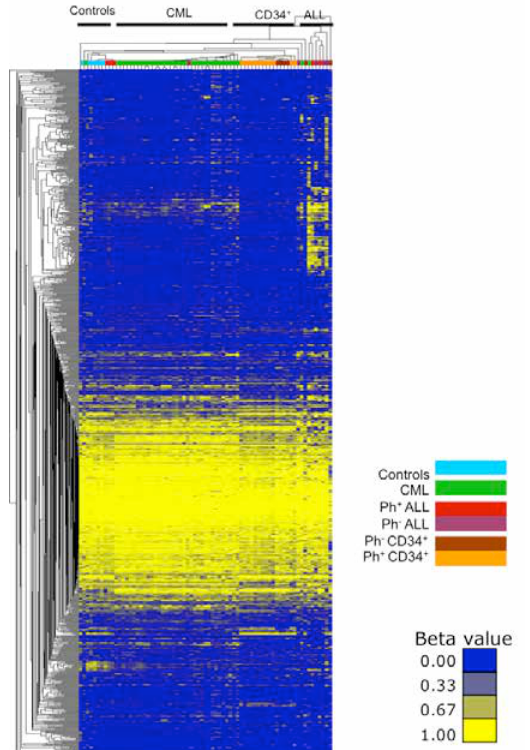
Figure 1: DNA methylation analysis of homogenous cancers. Two- dimensional unsupervised cluster analysis of DNA methylation in 36 CML, 18 APL and five GIST patients, and six samples of peripheral blood from healthy controls. DNA methylation at 972 CpG sites are shown, with probes corresponding to sites on the X-chromosome and those known to contain SNPs were sequestered and not used for downstream analysis. Red arrows indicate clusters of DNA methylation that are specific for each disease. Blue represents low levels of DNA methylation (beta value close to 0) and yellow repre- sents high level of DNA methylation (beta value close to 1).